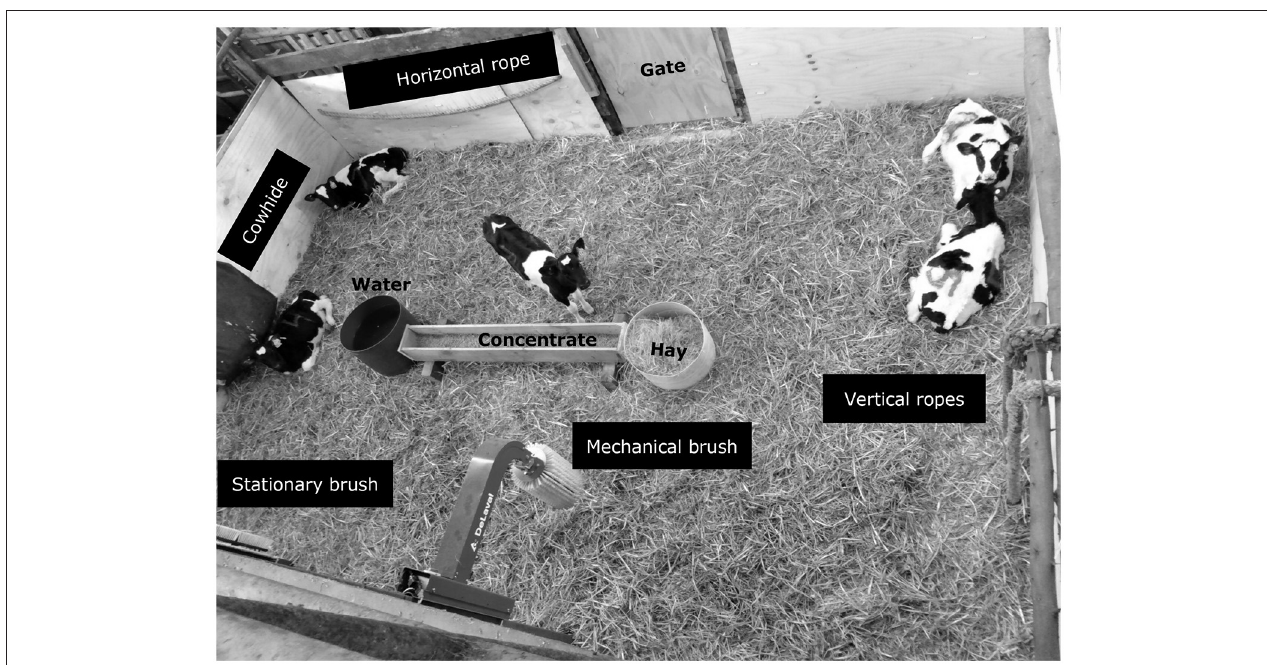
FIGURE 2 | Pen layout with location of the enrichment objects, hay, concentrate feeders, and water container.